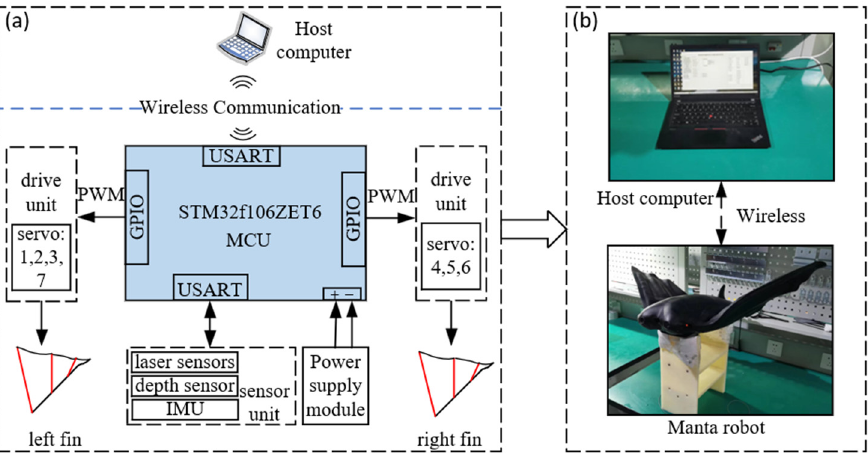
Figure 2. The control system of the manta robot. ( a ) Shows the block diagram of the manta robot control system, and ( b ) shows the physical diagram of the system.